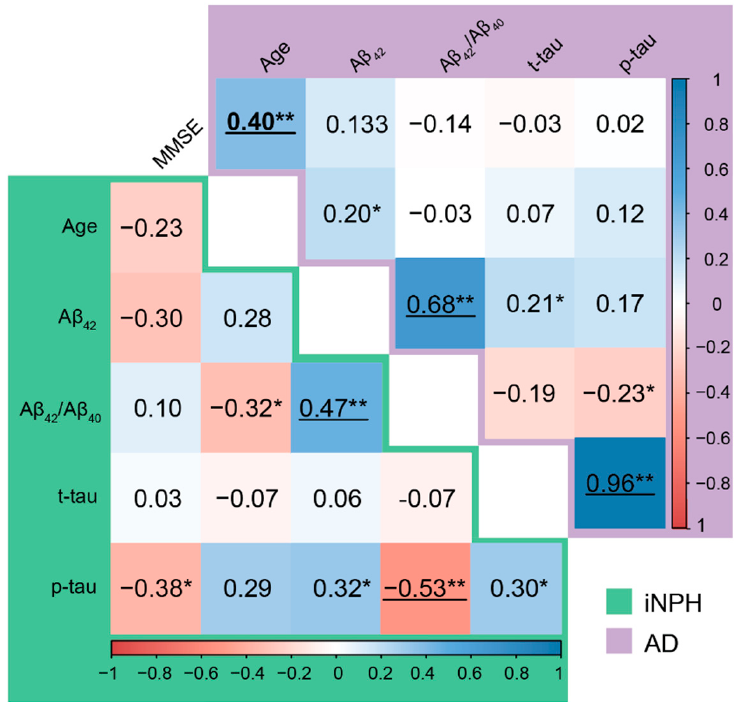
Figure 1. Correlation matrix. Values quoted in the correlation matrix are Pearson’s r correlation coefficients. Statistical significance received a Bonferroni adjustment and was accepted at p < 0.01 (significant correlations were reported as underlined characters). Color maps represent Pearson’s r correlation coefficients. * p < 0.05, ** p < 0.01.